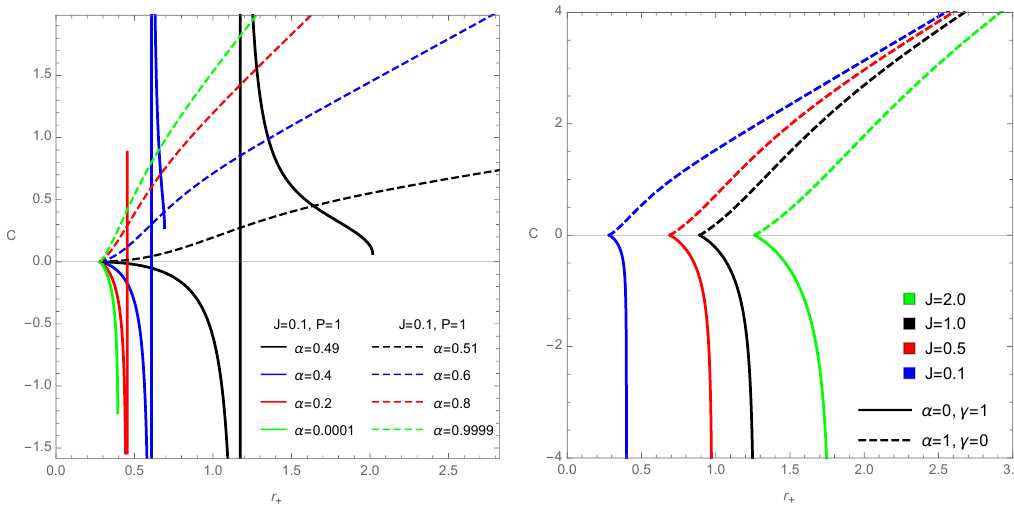
Figure 9 . Speci(cid:12)c heat: Left panel: di(cid:11)erent (cid:11) ’s and respective (cid:13) = 1 (cid:0) (cid:11) . Right panel: pure exotic and standard case for several values of